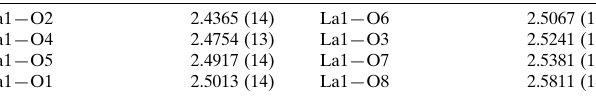
Selected bond lengths (A˚ ).